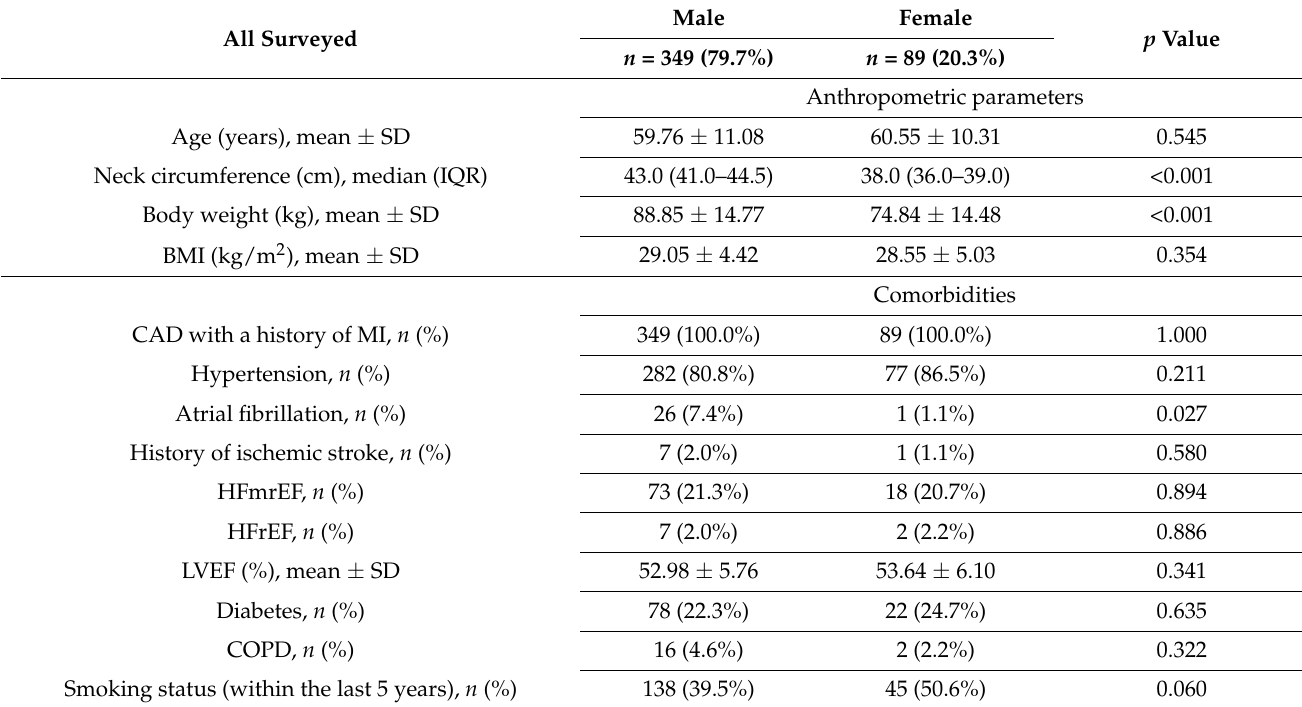
Table 2. Characteristics of anthropometric parameters and comorbidities in the surveyed men and